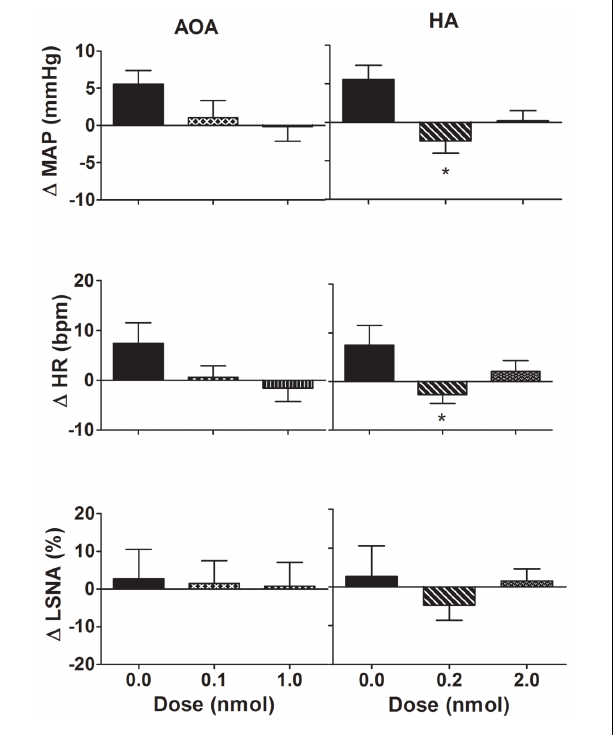
FIGURE 4 | Changes in mean arterial pressure (MAP), heart rate (HR), and lumbar sympathetic nerve activity (LSNA) following vehicle ( n = 14 for MAP and HR and n = 6 for LSNA) and amino-oxyacetate (AOA; 0.1–1.0nmol/side) and hydroxylamine (HA; 0.2–2.0nmol/side; n = 13 for MAP and HR; and n = 6 for LSNA) microinjected into the hypothalamic paraventricular nucleus inWKY rats. AOA and HA are inhibitors of the enzyme cystathionine- β -synthase. * P < 0.05 compared to vehicle. Different shaded bars represent a different dose of drug as